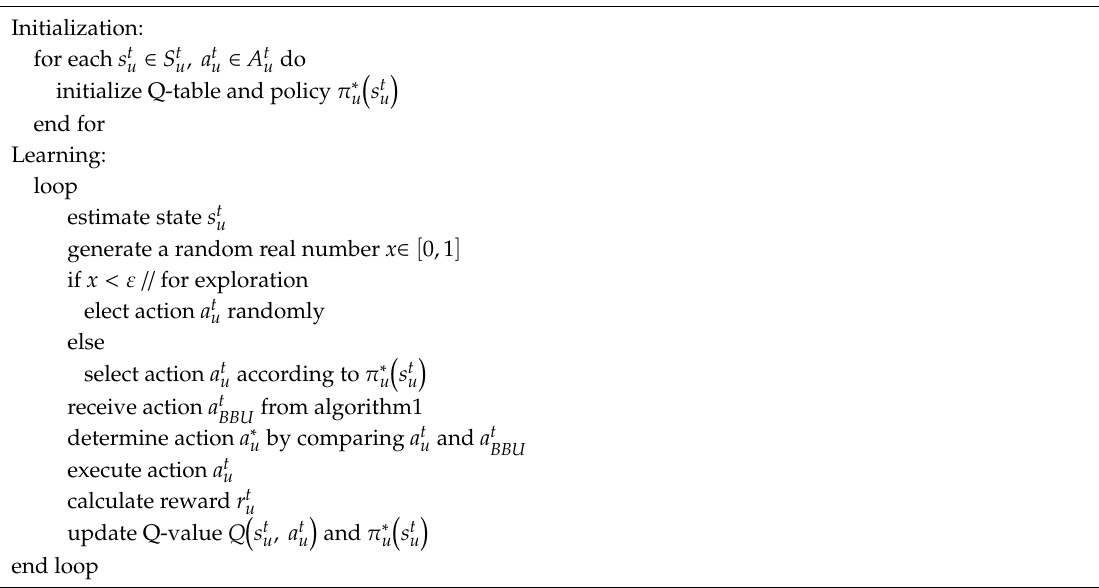
Algorithm 2: Pseudocode for distributed